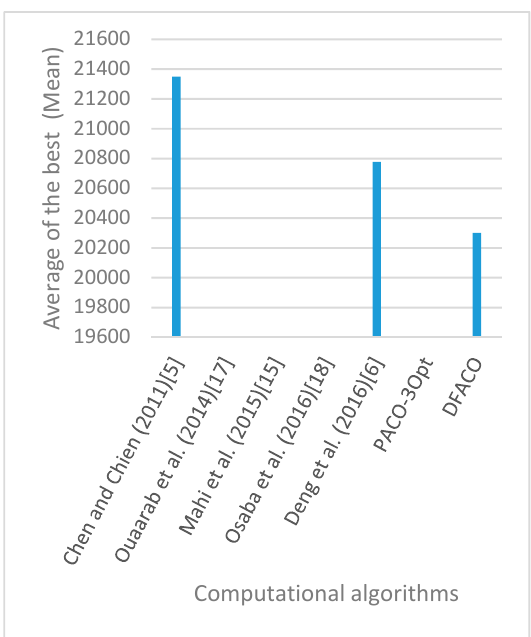
Figure 30. Average of best solutions obtained for instance fl1400 by all algorithms.